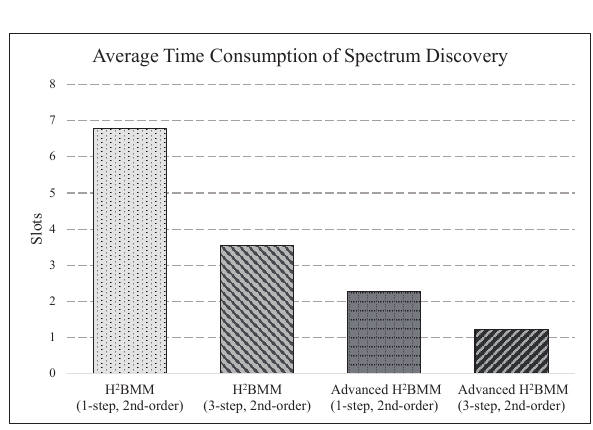
Figure 15. Time Consumption of Advanced H 2 BMM and H 2 BMM of higher prediction accuracy, smaller false alarm and miss detection probabilities, lower computation complexity and less time consumption on spectrum